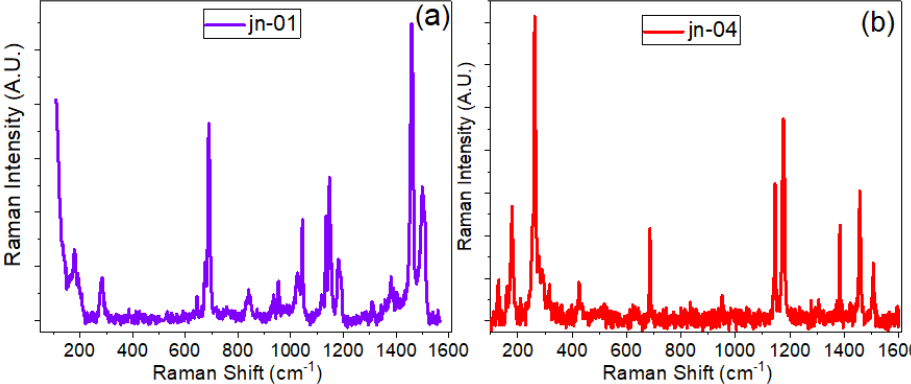
Figure 4. Raman spectra of ( a ) ZIF-8 and ( b ) ZIF-67-1.